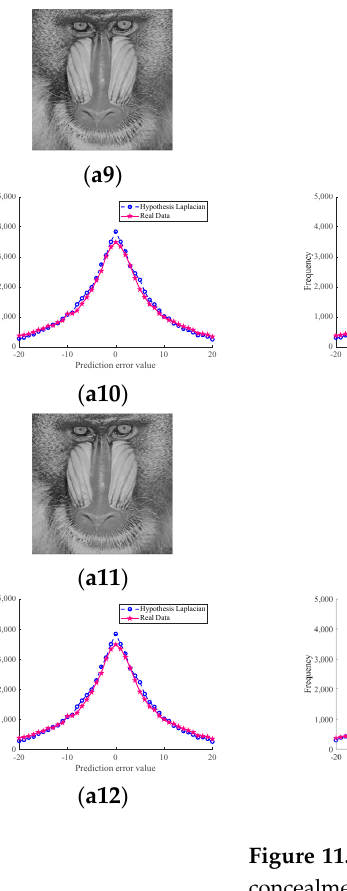
images by skipping HS (ER = 0.7 bpp, PSNR = 40.17 dB); ( a6 ) Histogram of (a5); ( b6 ) Histogram of proposed (ER = 0.1 bpp, PSNR = 41.25 dB); ( c7 ) Stego images by the proposed (ER = 0.4 bpp, PSNR = 33.43 dB); ( d7 ) Stego images by the proposed (ER = 0.7 bpp, PSNR = 27.50 dB); ( a8 ) Histogram of Stego images by traditional HS (ER = 0.1 bpp, PSNR = 45.62 dB); ( c9 ) Stego images by traditional HS